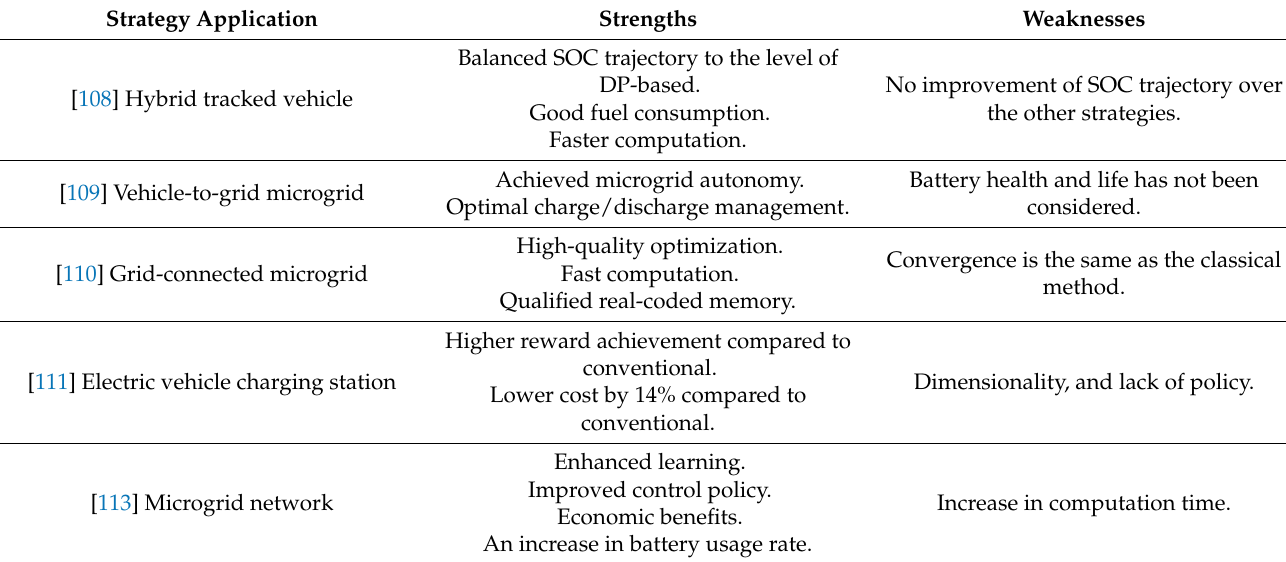
Table 4. Summary of intelligent strategy-based reinforcement